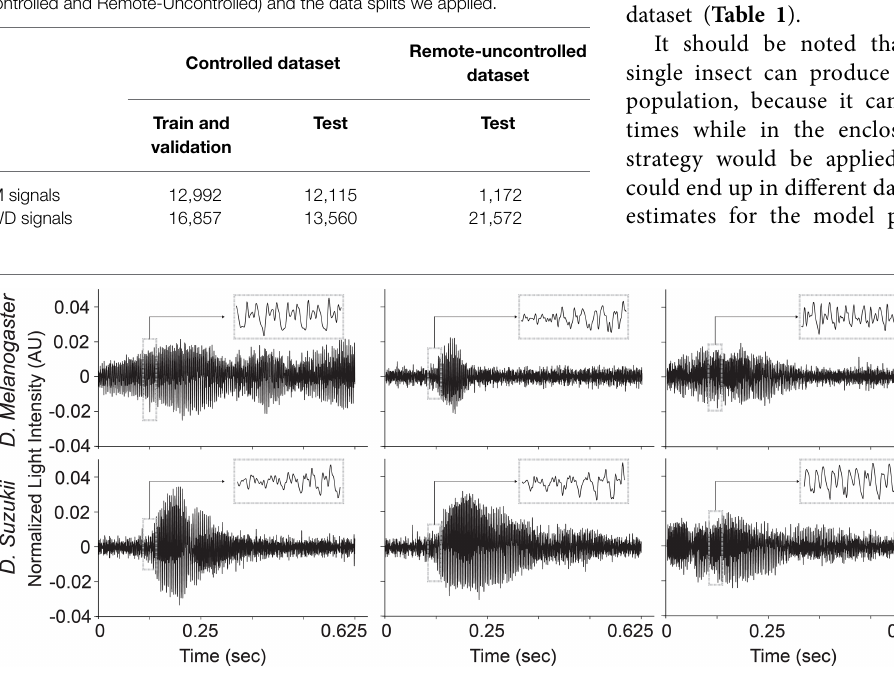
FIGURE 3 | Illustrations of different wingbeat time signals of Drosophila suzukii and of Drosophila melanogaster